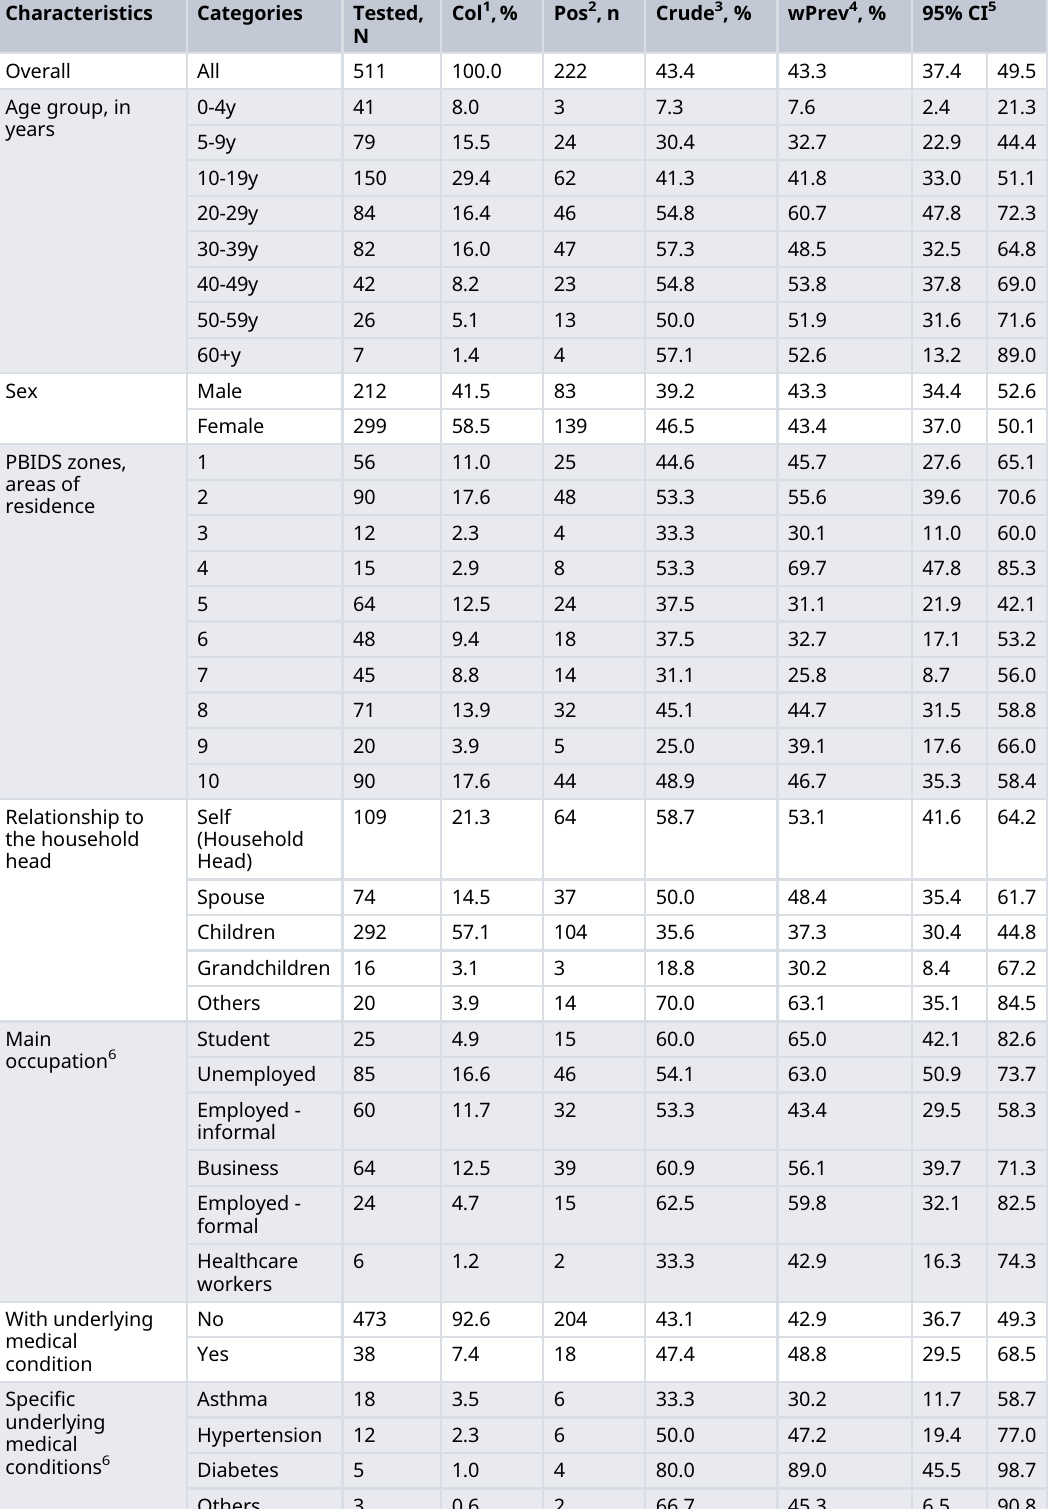
Table 1. Participant characteristics and seroprevalence of severe acute respiratory syndrome coronavirus-2 in Kibera urban informal settlement, Nairobi, Kenya. Characteristics